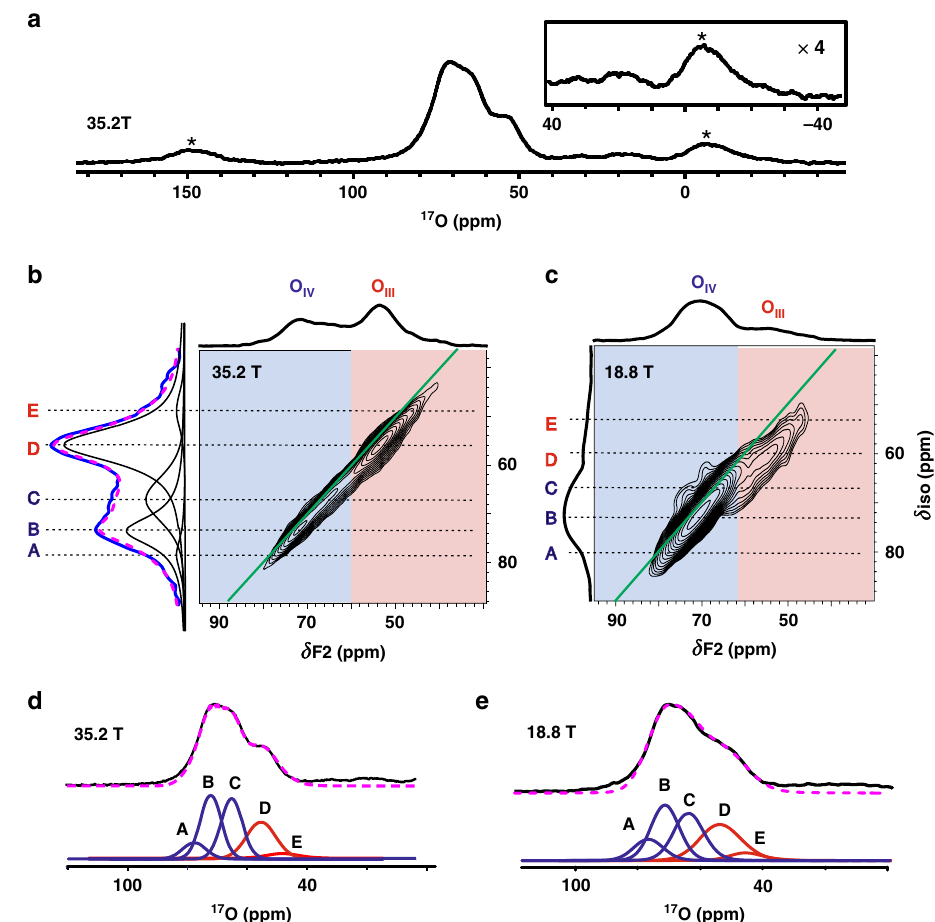
Fig. 1 Identi fi cation of oxygen sites by 1D 17 O MAS NMR and 2D 17 O 3QMAS NMR. a 1D 17 O MAS NMR spectrum of γ -Al 2 O 3 acquired at 35.2T and partially enlarged 17 O spectrum, b sheared 2D 17 O 3QMAS spectrum of γ -Al 2 O 3 recorded on 35.2T and projection (blue) in isotropic dimension with the simulated spectrum (purple) deconvoluted by fi ve individual Gaussian lines (black, A-E denote as fi ve individual oxygen sites), c sheared 2D 17 O 3QMAS spectrum of γ -Al 2 O 3 recorded at 18.8 T. Green lines in 2D spectra represent chemical shift/diagonal axis ( C Q = 0). O IV and O III denote 4-coordinated and 3-coordinated oxygen sites, respectively. d , e The best- fi t simulation spectra (purple) of the 1D 17 O MAS NMR spectra (black) of γ -Al 2 O 3 obtained at 35.2 T and 18.8 T. The 1D spectra are deconvoluted with the DMFIT program 57 according to the NMR parameters of fi ve oxygen sites (A-E) in Table S1. The acquisition times of the 2D 17 O 3QMAS spectra at 35.2T and 18.8 T are ca. 0.53h and ca. 40h, respectively. Asterisks denote spinning